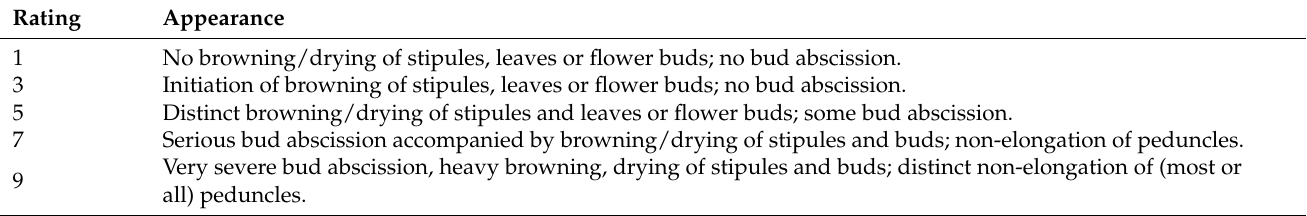
Table 1. Scale for rating the flower bud thrips damage in